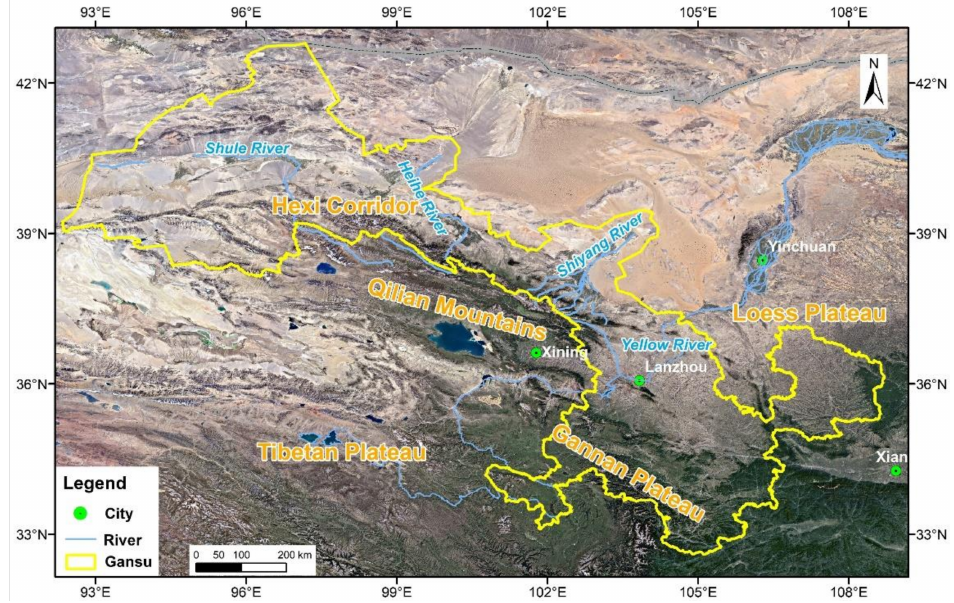
Figure 1. Geographical location of the Gansu